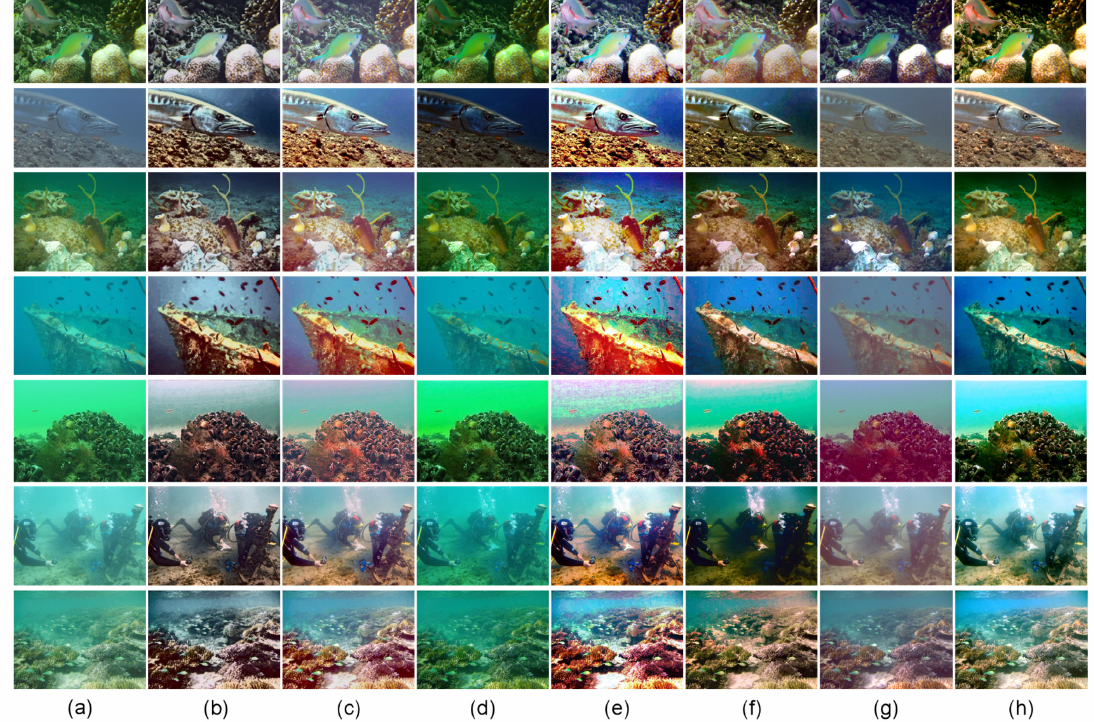
Figure 11. Visual comparison for recovered results on real-world underwater images. ( a ) underwater images; ( b ) the results of Fu et al. [13]; ( c ) the results of Zhang et al. [12]; ( d ) the results of Drews et al. [20]; ( e ) the results of Li et al. [24]; ( f )the results of Berman et al. [25]; ( g ) the results of Shin et al. [29]; ( h ) the results of the proposed